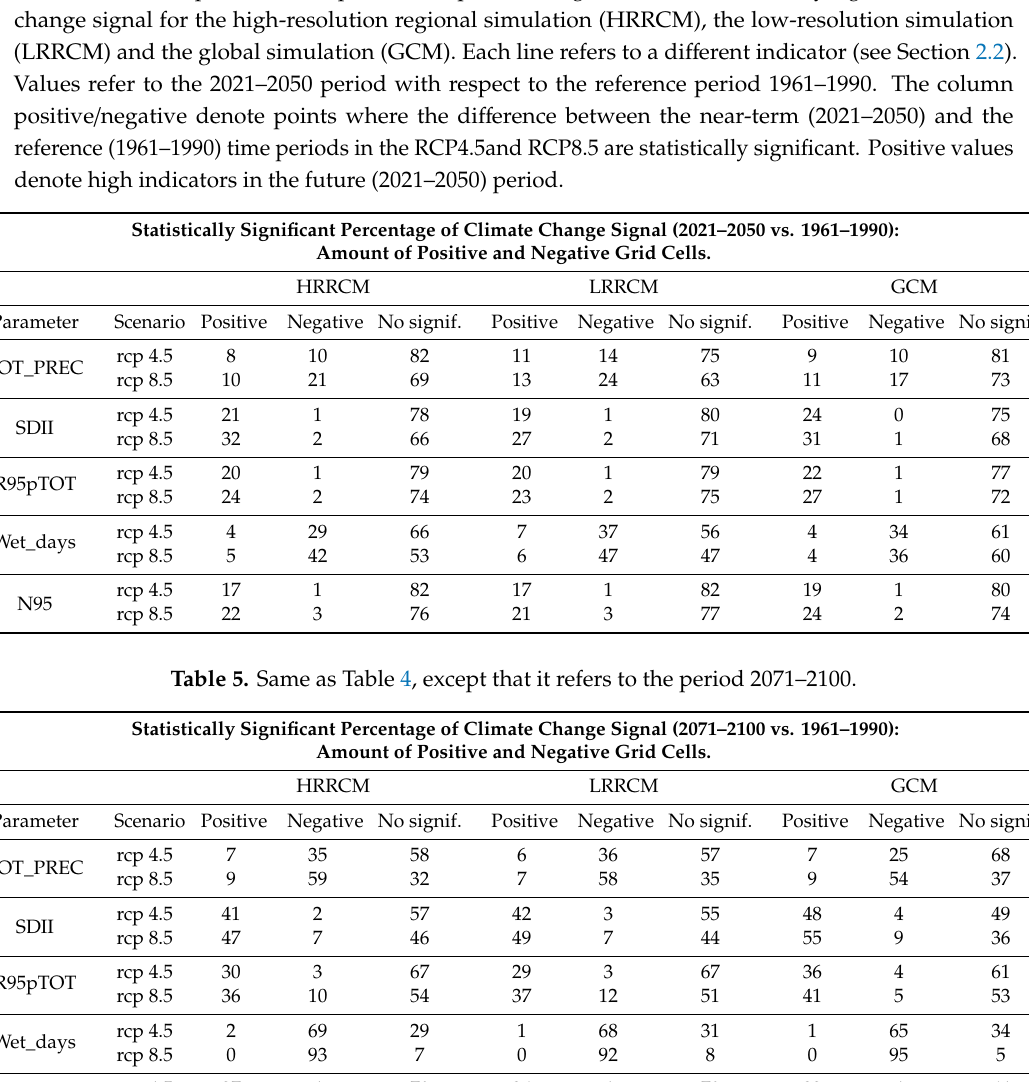
Parameter Scenario Positive Negative No signif. Positive Negative No signif. Positive Negative No